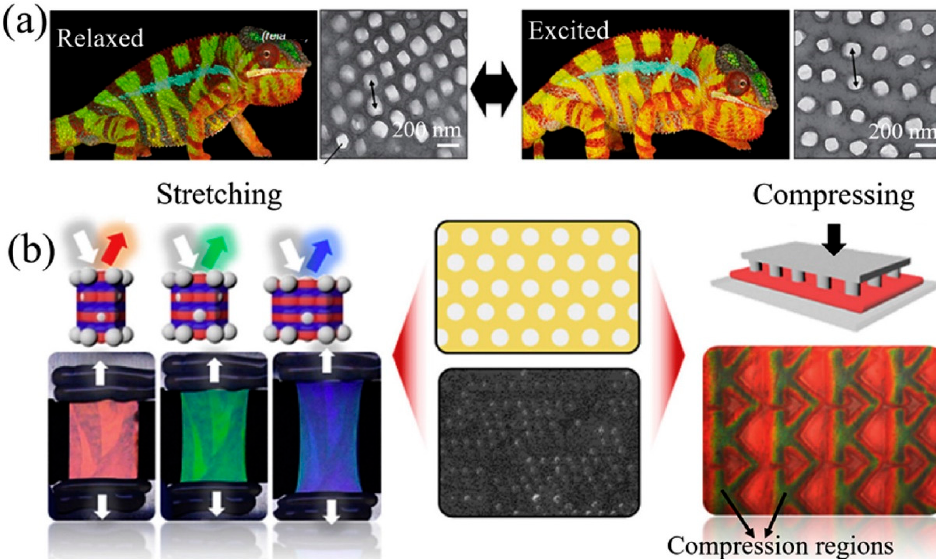
Figure 9. Bioinspired nanomaterials that respond to stimuli. ( a ) A chameleon in the relaxed (green color, left) and excited (yellow color, right) state. The transmission electron microscope images on the right of each panel show the periodic changes in regular arrays of guanine nanocrystals. ( b ) The color change of an artificial film upon stretching and compression [120]; © American Chemical Society, 2017.